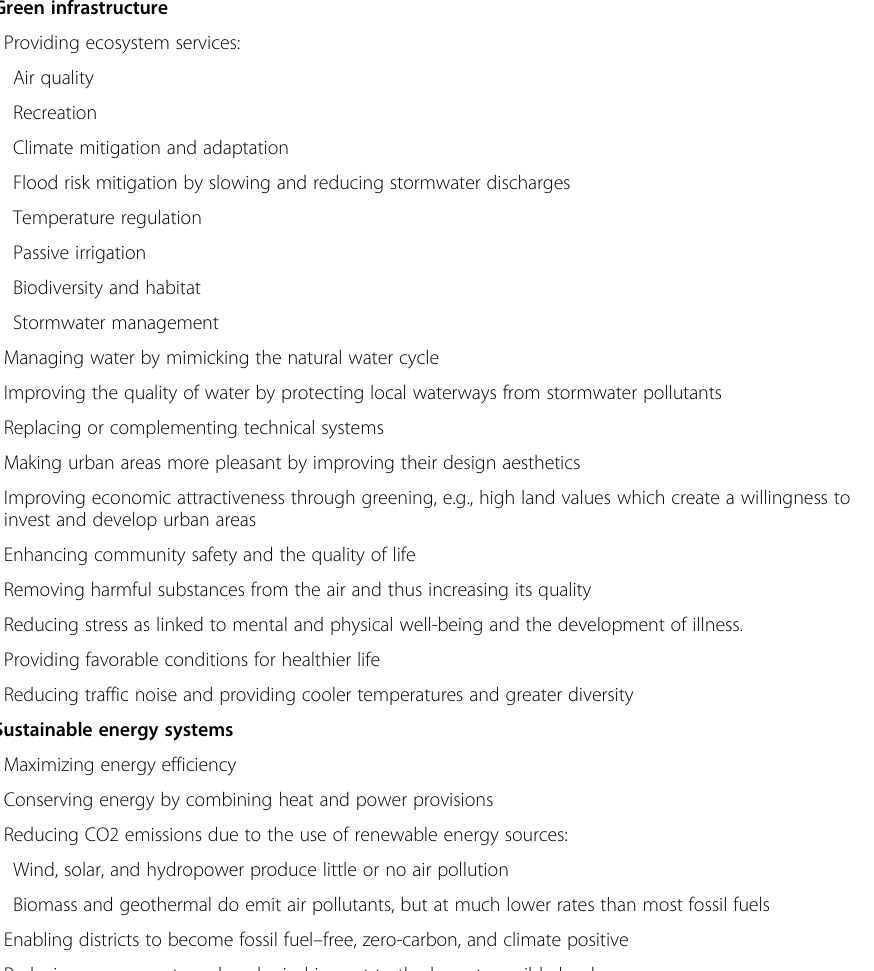
Table 4 The key environmental and some economic benefits of the eco-city Green